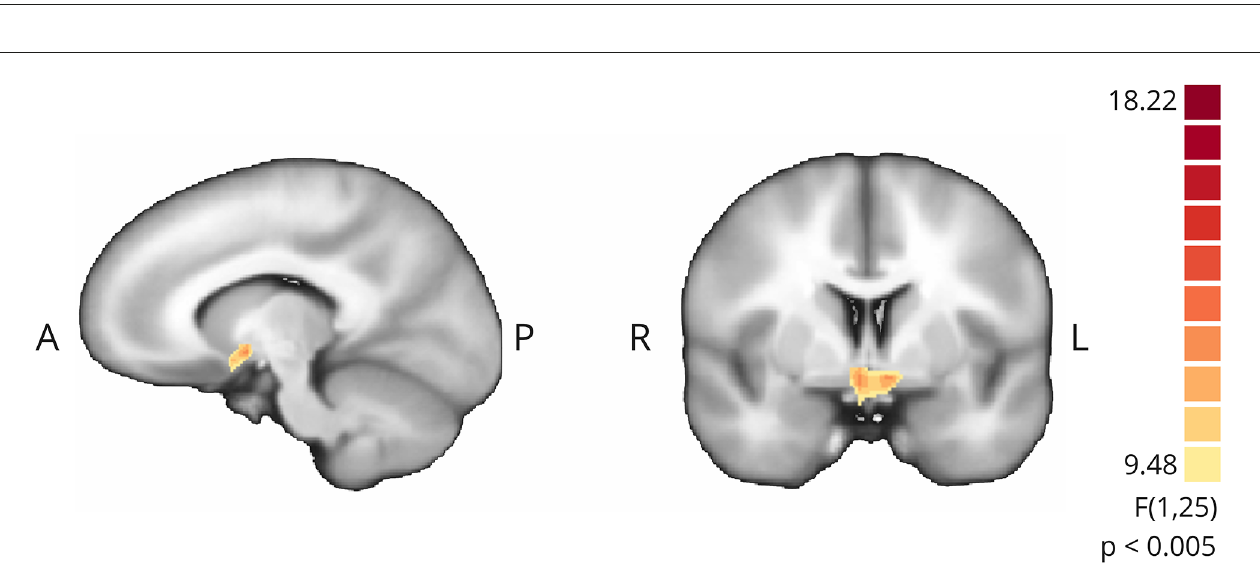
FIGURE7 Whole-brain exploratory analysis (mixed ANOVA, p < 0.005, non-corrected) between active NF and sham groups. Positive cluster in ventral striatum